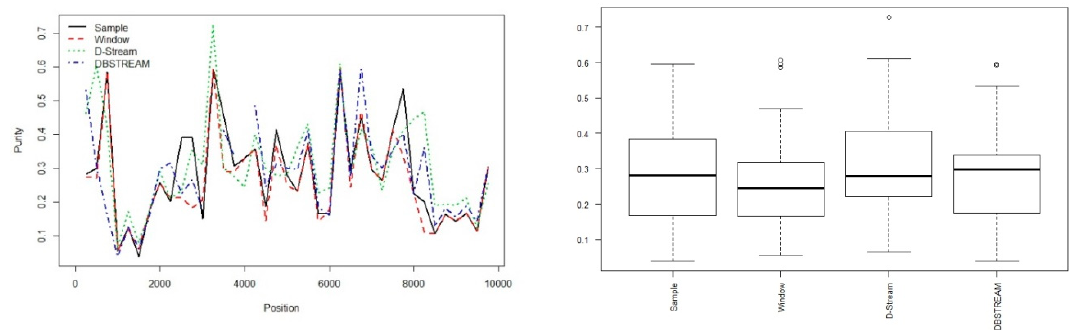
Figure 10. Evaluation of data stream clustering of an evolving stream (using real data stream).